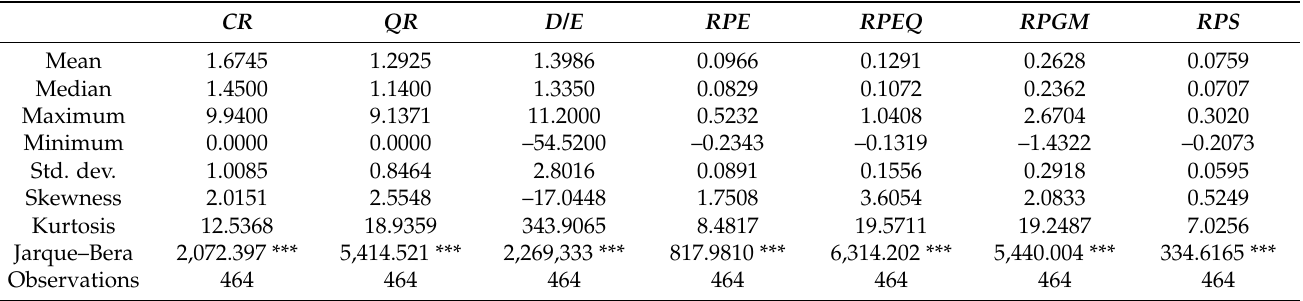
Table 2. Descriptive statistics for gas companies.